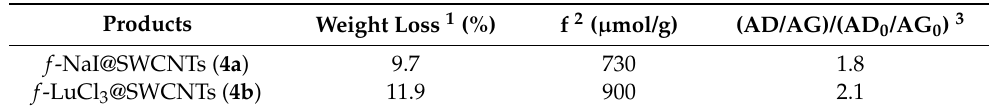
Table 1. Screening of different SWCNTs filled with biomedical relevant payloads and modified by oxidation and amination.